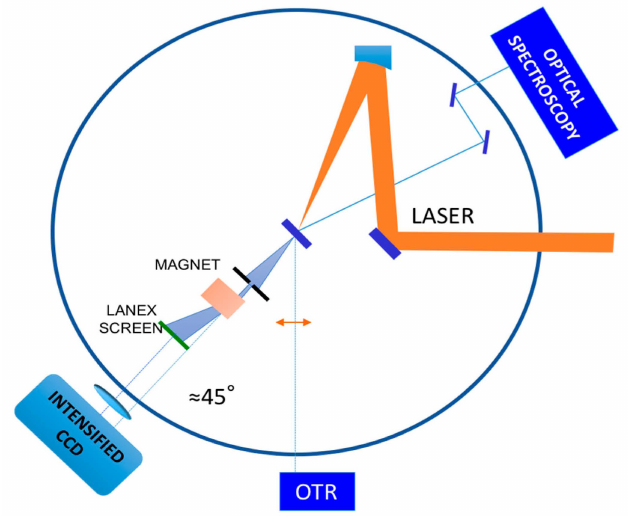
Figure 4. Schematic view of the experimental setup showing the main diagnostics, including the optical spectroscopy of the specular reflection, the rear side optical imaging, and the magnetic electron spectrometer of the forward escaping electrons. A Thomson Parabola ion spectrometer was used in place of the electron spectrometer to detect forward accelerated ions. CCD: Charge Coupled Device; TR: Optical Transition